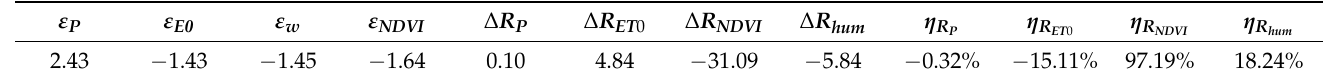
Table 2. Contribution rate analysis of the discharge variation in the